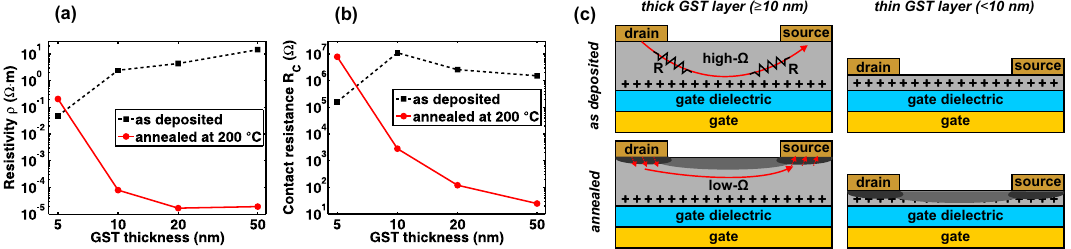
Figure 5. Influence of GST thickness and annealing on resistivity and contact resistance. ( a ) Resistivity ρ . ( b ) Contact resistance R C . ( c ) Sketch visualizing the proposed